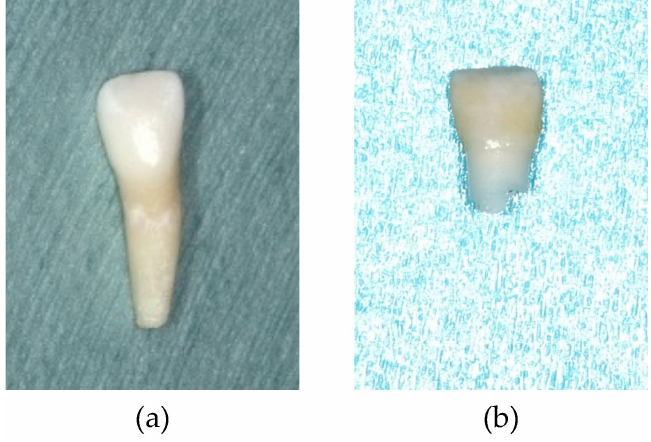
Figure 1. Exfoliated mandibular primary central incisors: ( a ) Older sister (seven years and three months); ( b ) Younger sister (six years and one